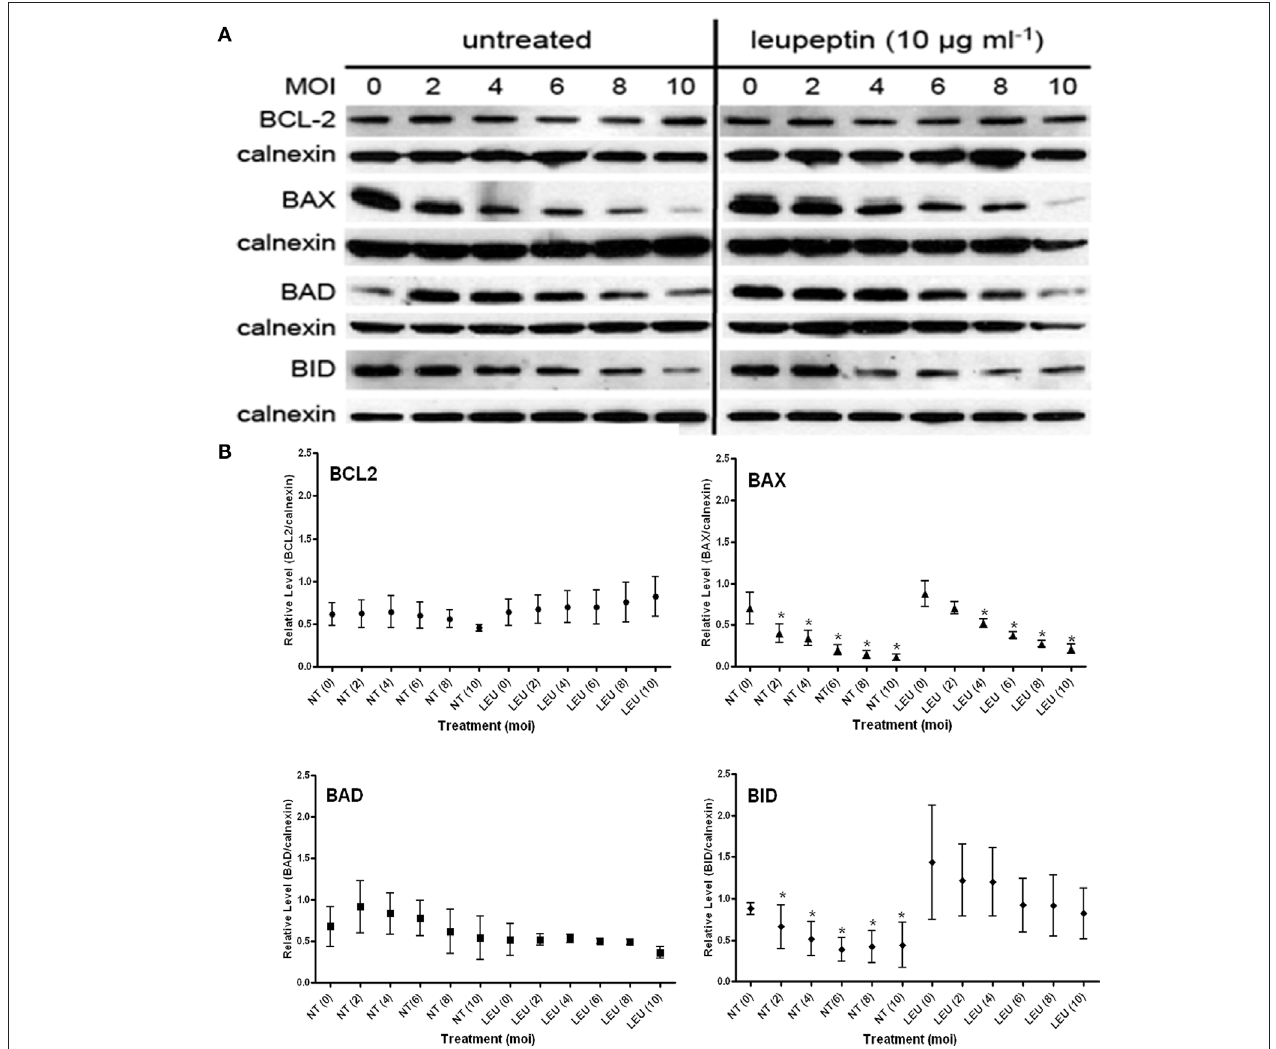
Figure 5 | effect of trypsin-like serine protease inhibition with leupeptin on the steady state levels of BCL2-family proteins in both uninfected (MOi = 0) and infected cells (MOi 2–10). (A) Representative immunoblots detecting the levels of the indicated BCL2-family members in response to increasing infection. Levels of calnexin are used as a loading control. (B) Quantification of the levels of specific BCL2-proteins relative to calnexin in response to increasing infecting dose. Profiles for no-treatment (NT, untreated) and treated (Leu) samples are indicated along with the MOI in